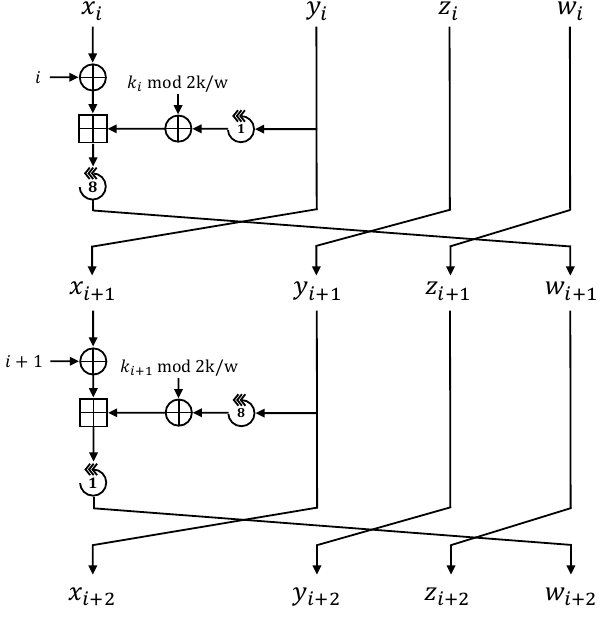
Figure 3. Round function of